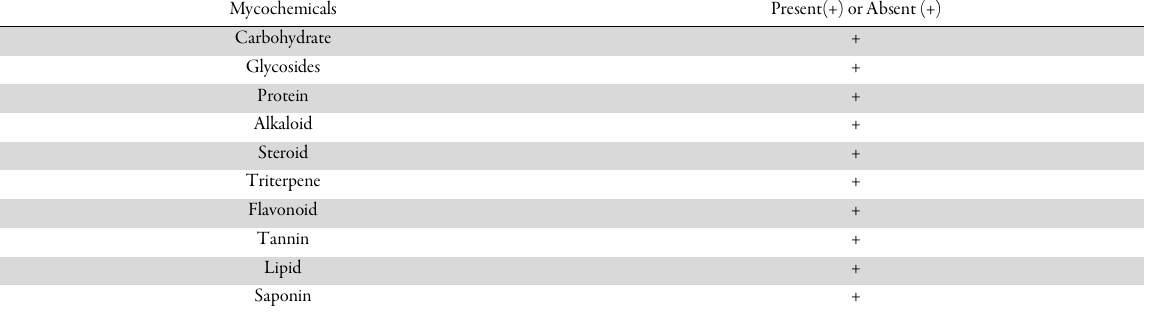
Table 1. Screening of proximate mycochemicals present in aqueous fruiting body extract of G. applanatum